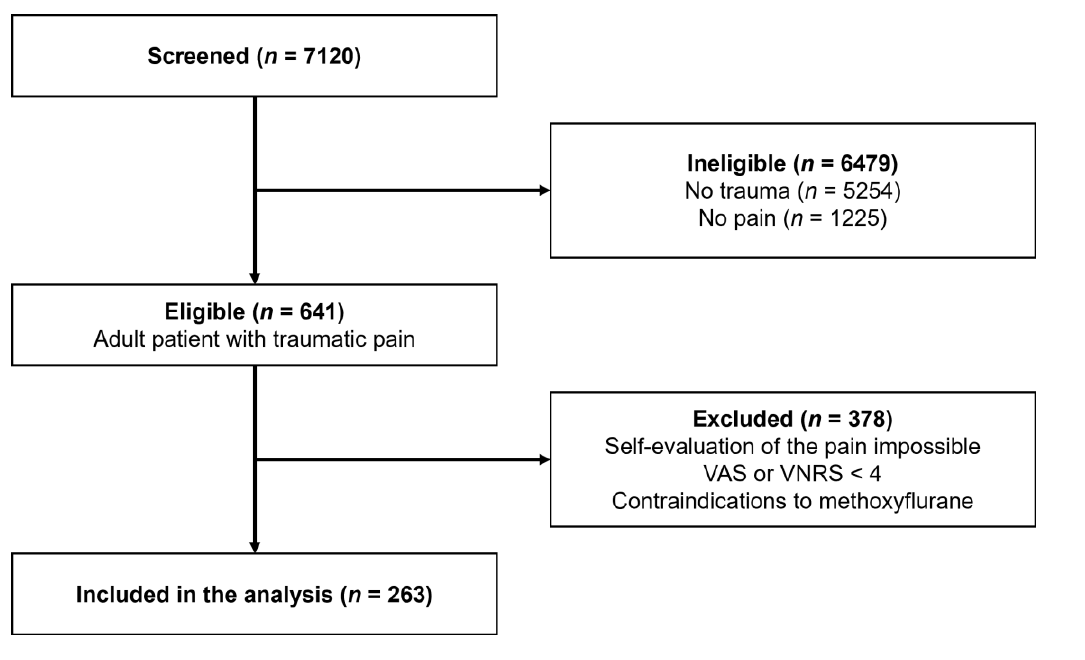
Figure 1. Flowchart. Table 1. Patients